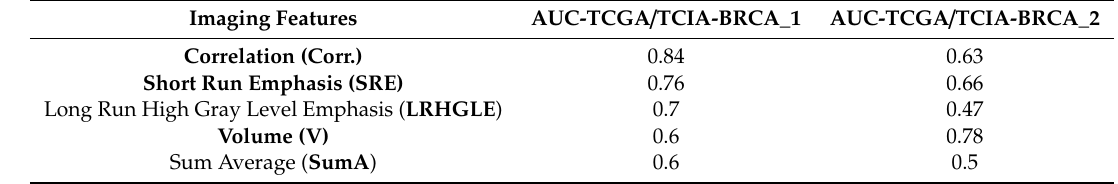
Table 2. Results of the classification of imaging features in TCGA / TCIA-BRCA_1 and TCGA / TCIA-BRCA_1 datasets.